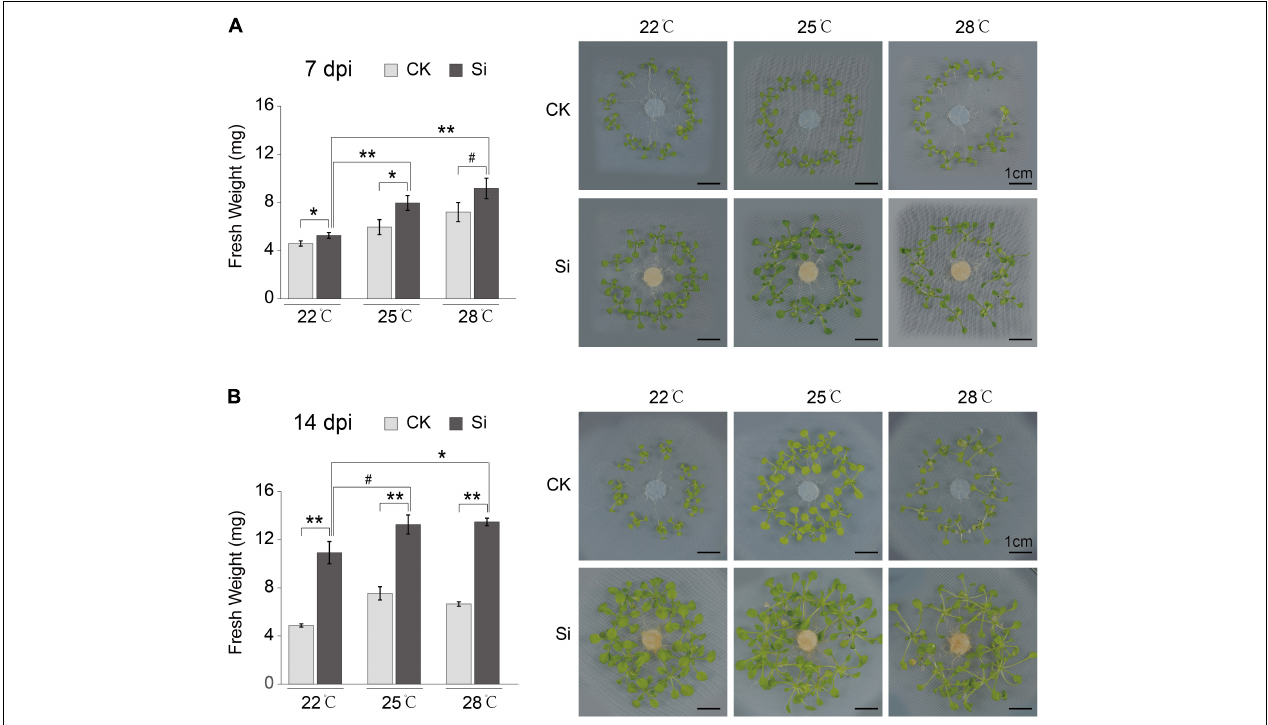
FIGURE 1 | High ambient temperature strengthened the growth promotion effect of S. indica on Arabidopsis. Arabidopsis thaliana col-0 WT plants were cocultured with the endophytic fungus S. indica at different temperatures. S. indica significantly promoted the growth of Arabidopsis seedlings at 22, 25, and 28 ◦ C. The photos showed the control (CK) and S. indica cocultivated (Si) seedlings at the 7 days post inoculation (dpi) (A) and 14 dpi (B) . Fresh weights of seedling aboveground parts at 25 and 28 ◦ C were heavier than that at 22 ◦ C, which suggested that the growth promotion effect of S. indica was enhanced by elevated ambient temperature. Error bars indicate SE ( n ≥ 3). Significance analysis of differences between CK and Si samples were performed by t -test (** P < 0.01; * P < 0.05; # P <